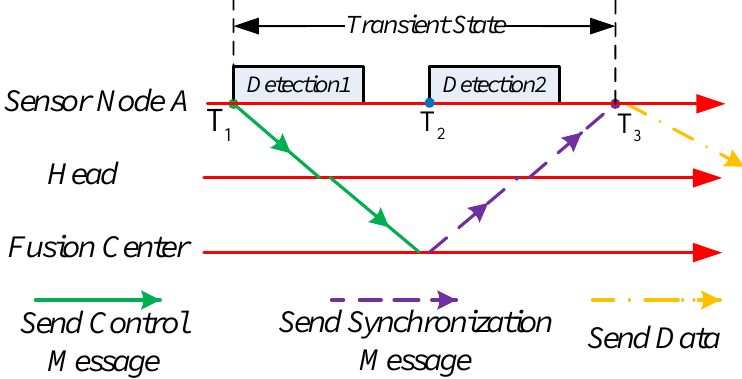
Figure 6. Node behaviors when the system transits from the sleep mode to the detection